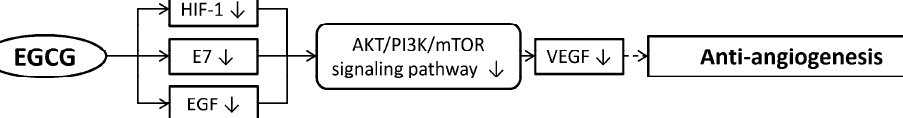
Figure 2. Molecular mechanisms of EGCG inhibiting angiogenesis. EGCG down-regulated the expressions of HIF-1, E7 and EGF, resulting in VEGF down-regulation through AKT/PI3K/mTOR signaling pathways. The decline of VEGF could inhibit angiogenesis (a broken line means indirect approach). AKT: protein kinase B; E7: another HPV oncogene; EGF: epidermal growth factor; HIF-1: hypoxia-inducible factor 1; mTOR: mammalian target of rapamycin; PI3K: phosphoinositide-3-kinase; VEGF: vascular endothelial growth factor.